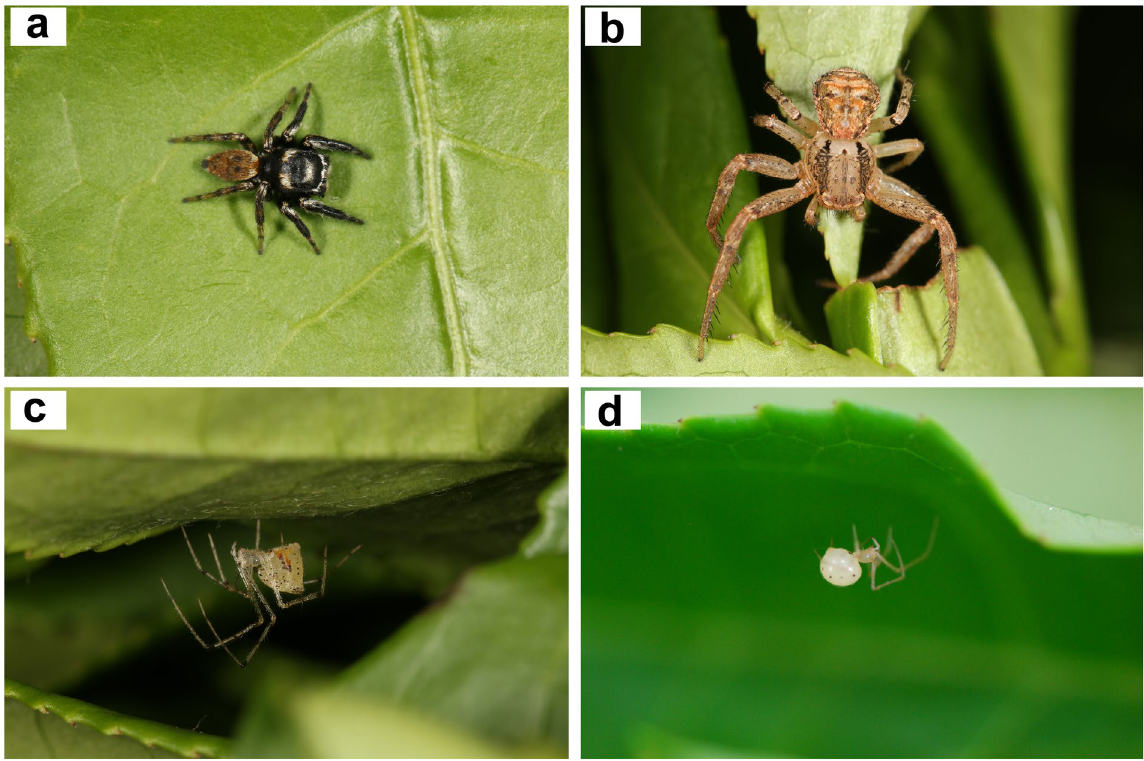
Figure 1. Four dominant spider species in the canopies of tea in the study area. ( a ) E . albaria (male); ( b ) X . ephippiatus (female); ( c ) M . pulcherrima (female); ( d ) C . octomaculatum (female). Photos taken by first